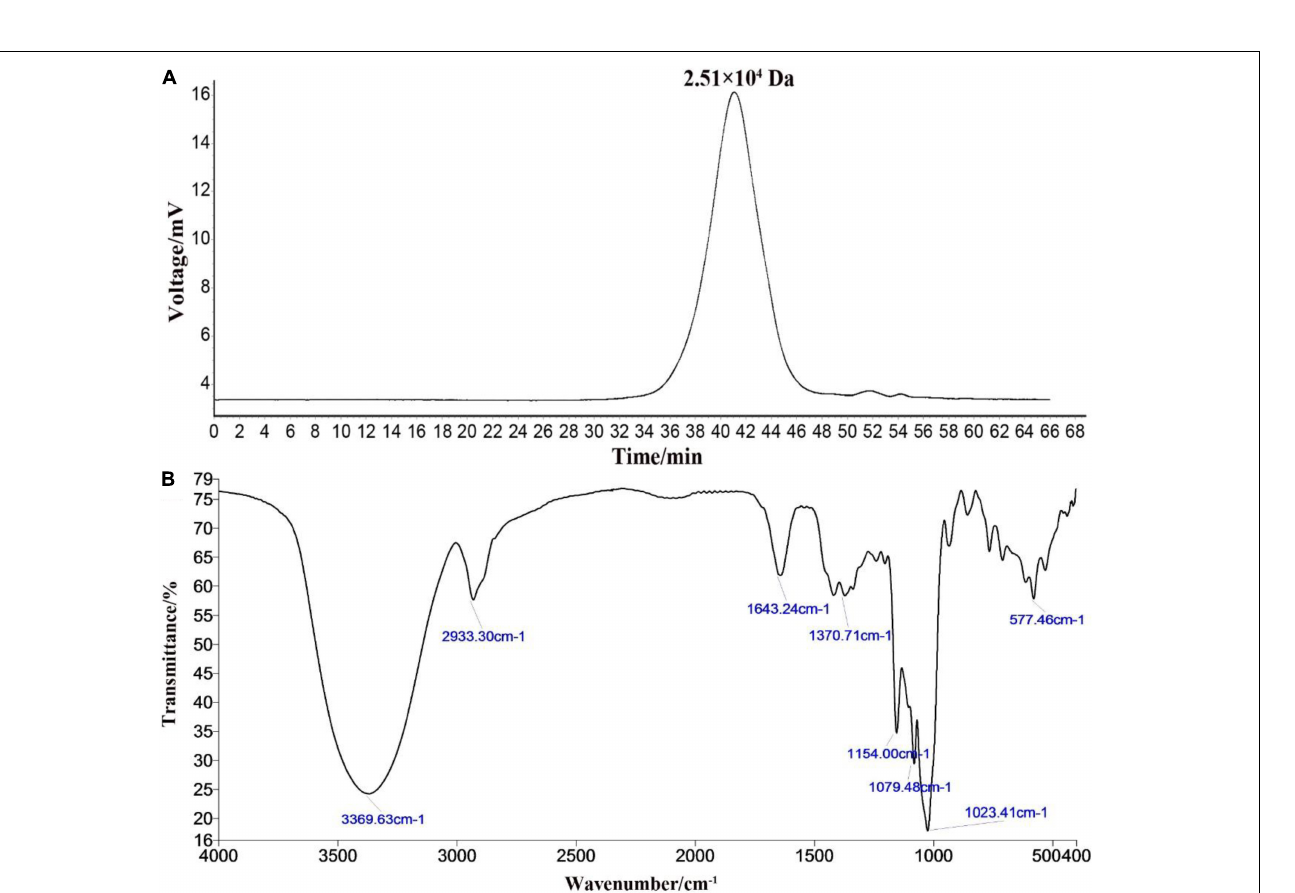
Frontiers in Nutrition |